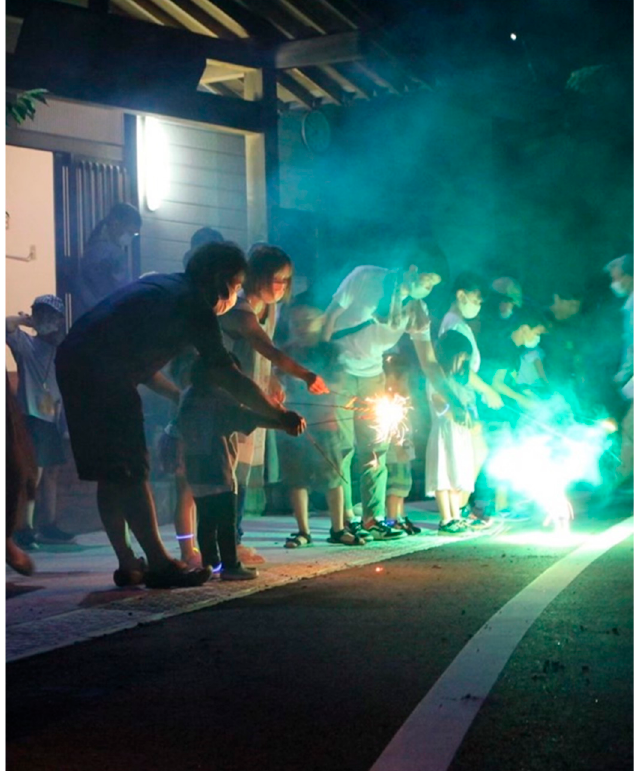
Figure 6. Yodo festival in which children participated (obtained by Ai Ichinose [the second author] on 23 July 2021). on 23 July